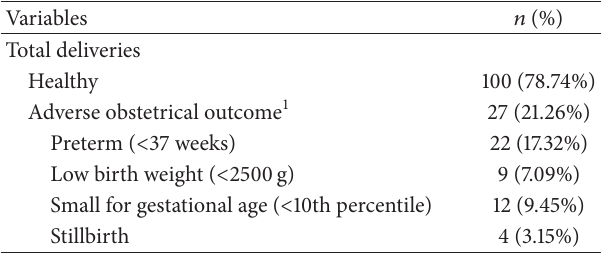
Table 1: Obstetrical outcomes among 127 births from women living with HIV from 1990 to 2010.